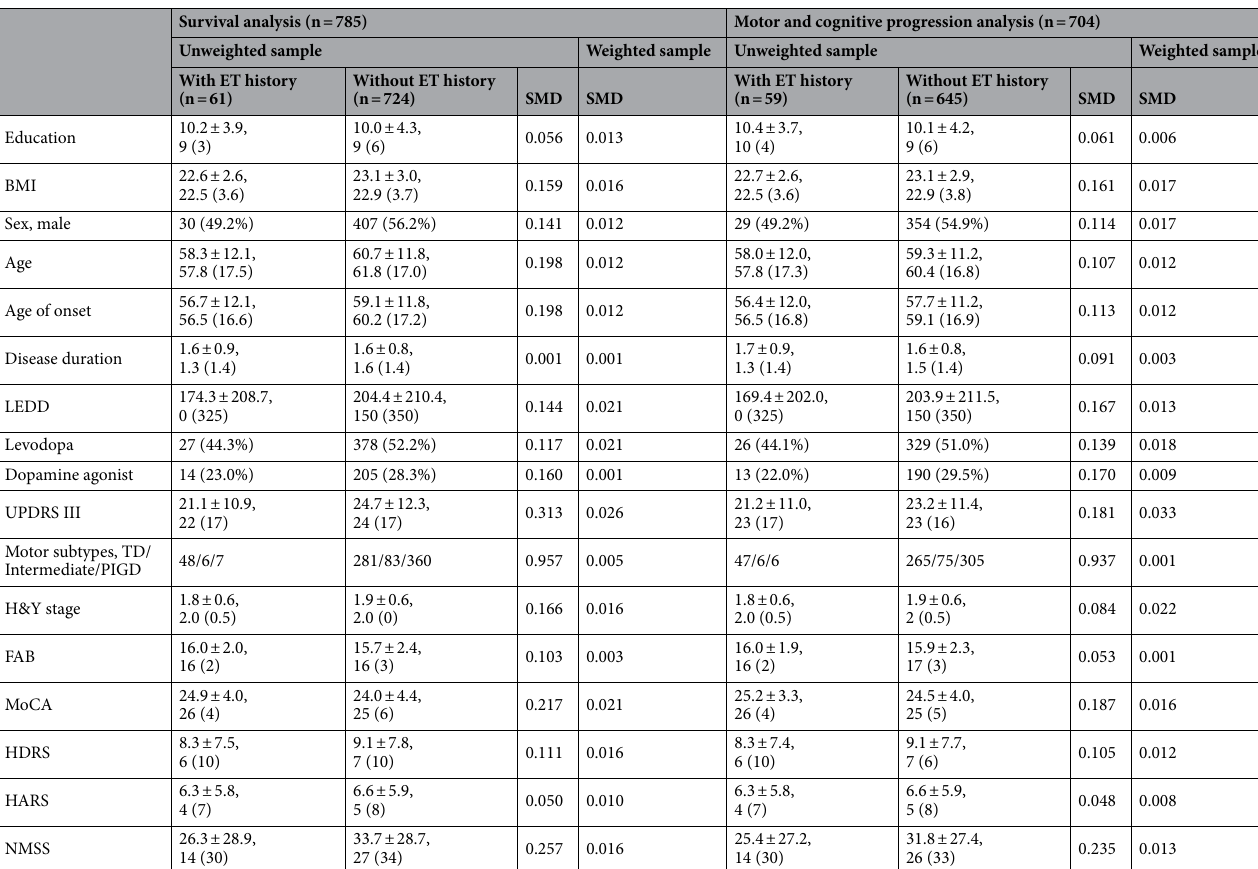
Table 1. Demographic and baseline clinical features between PD patients with and without a positive ET history. PD: Parkinson’s disease. ET: Essential tremor. SMD: standardized mean differences. BMI: body